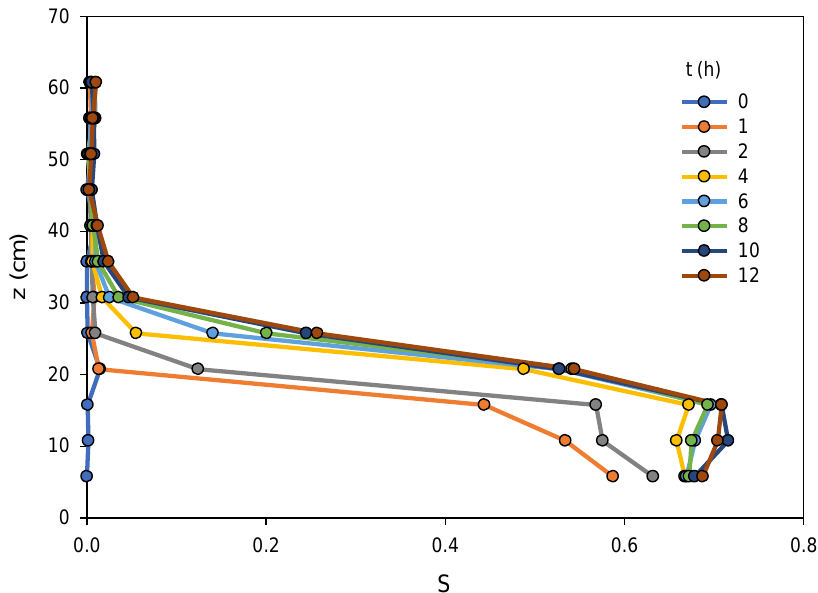
Figure 2. Elevation above the water table (z) vs saturation (S) measured over the first 12 h of the imbibition experiment.